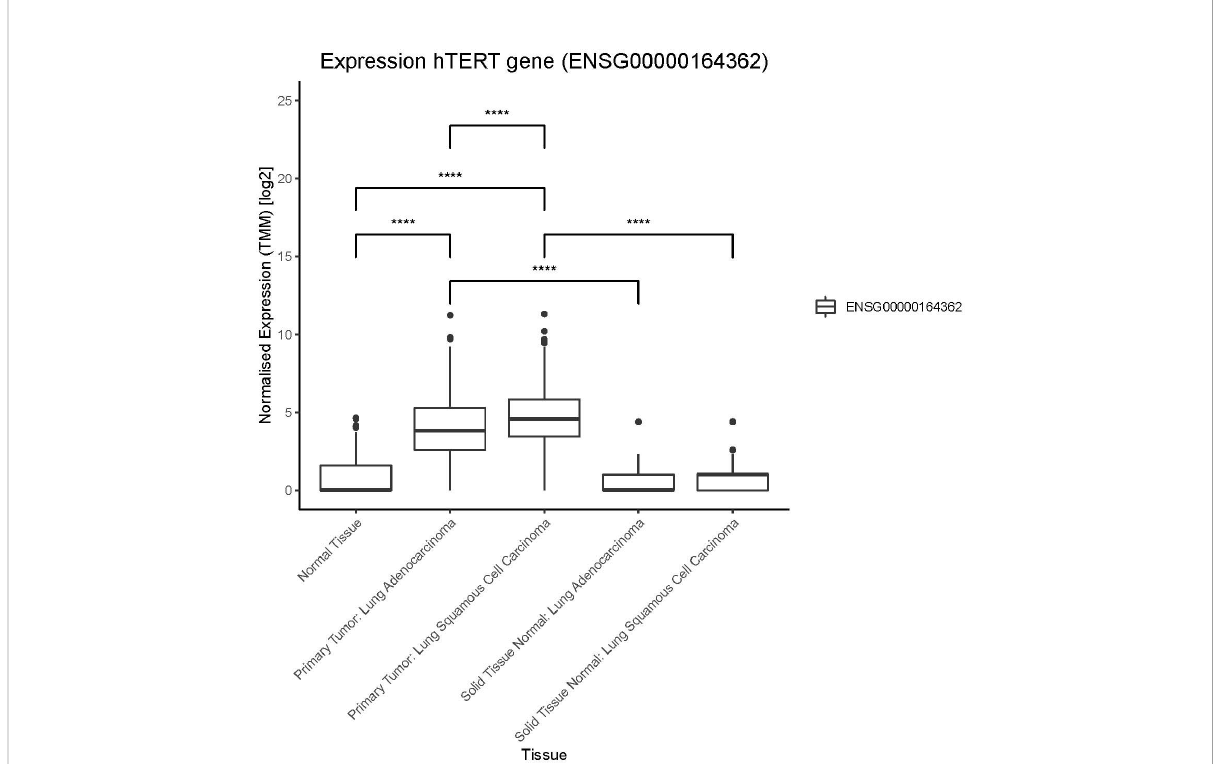
FIGURE 2 hTERT expression in lung cancer patients. Expression of hTERT in normal tissue (GTEX), primary tumors and solid tissue normal (TCGA). Solid tissue normal represents normal tissue from the same cancer patients. Signi fi cant differences between normal tissue and primary tumors, as well for solid tissue normal (not indicated in fi gure). Number of samples per group: normal tissue: 288, primary tumor lung adenocarcinoma: 513, primary tumor lung squamous cell carcinoma: 498, solid tissue normal lung adenocarcinoma: 59, solid tissue normal lung squamous cell carcinoma: 50. Signi fi cance tested using pairwise.wilcox.test, padj < 0.0001 indicated with (****). P value adjustment method: